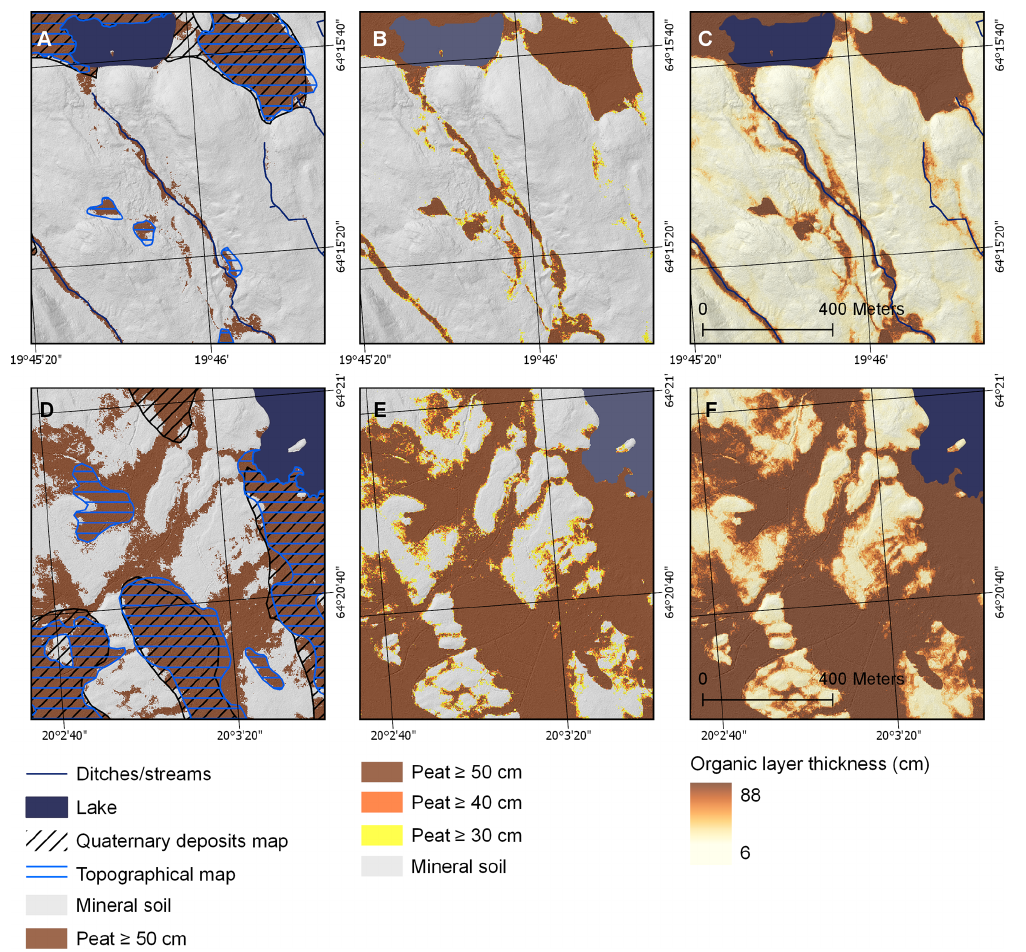
Figure 5. The left panels (a, d) show an example of two different locations with peatlands with the following three maps overlaid on each other for comparison: Quaternary deposits map (1 : 25000) (black hatched area), topographical map (1 : 12500) (blue hatched area), and the predicted peat ≥ 50cm map (2m resolution) (brown area). The center panels (b, e) demonstrate the difference in the predicted peat maps using 30, 40, and 50cm organic layer thresholds by superimposing the predictions on top of each other with peat ≥ 30cm in the bottom (a wider distribution) and peat ≥ 50cm at the top (a narrower distribution). The right panels (c, f) exemplify the continuous map of organic layer thickness derived using Eq. (7) in two different areas. Note that the thickness of the organic layer may be underestimated in some areas as the full depth of the organic deposits are not registered in the Swedish Forest Soil Inventory database (ranges